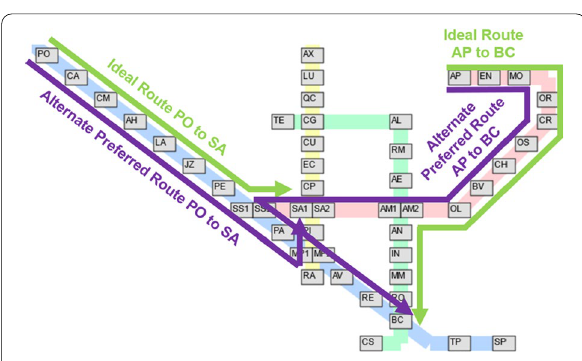
Fig. 14 Visualizations of selected examples (h) and (k)